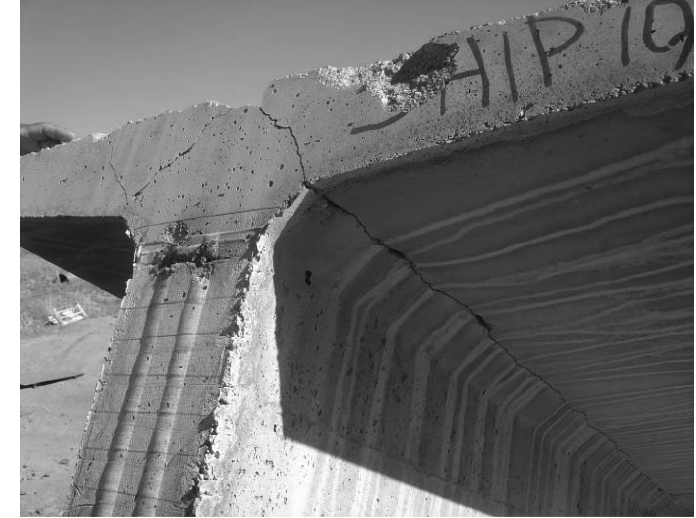
Fig. 13. Longitudinal cracking at web- fl ange intersection.